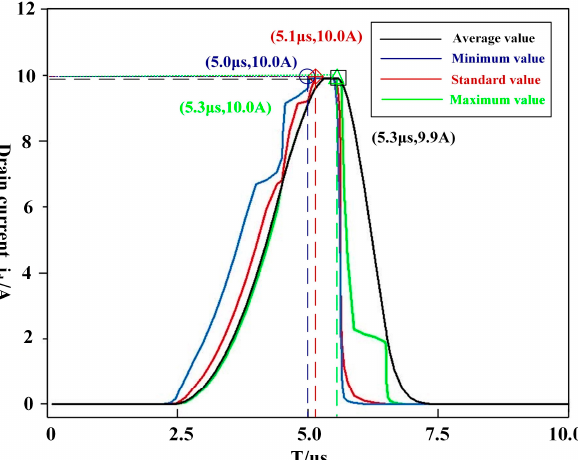
Figure 11. Simulation curves of i d and the maximum value, standard value, average value, and minimum value of C gs .